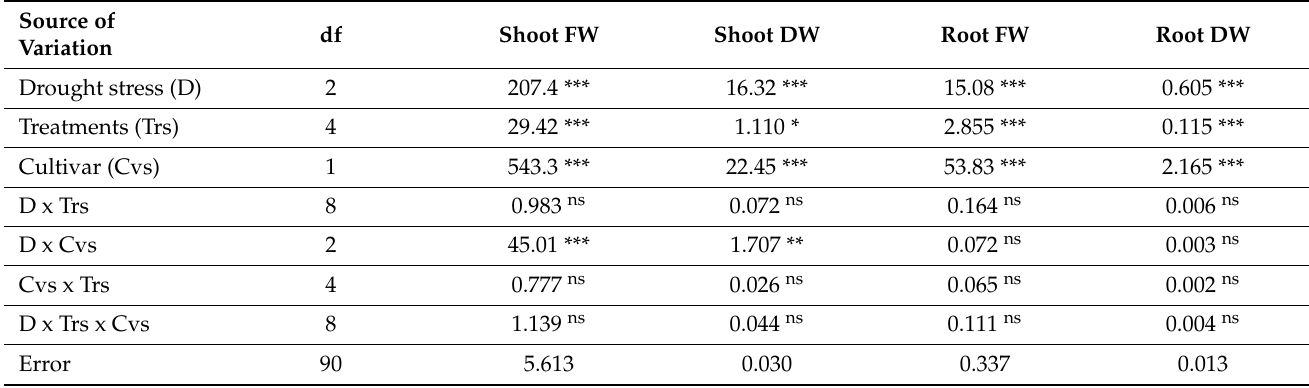
Table 1. Analyses of variance data for growth attributes of maize cultivars subjected to varying levels of sugar beet extract (SBE) and glycine betaine under water deficit conditions.